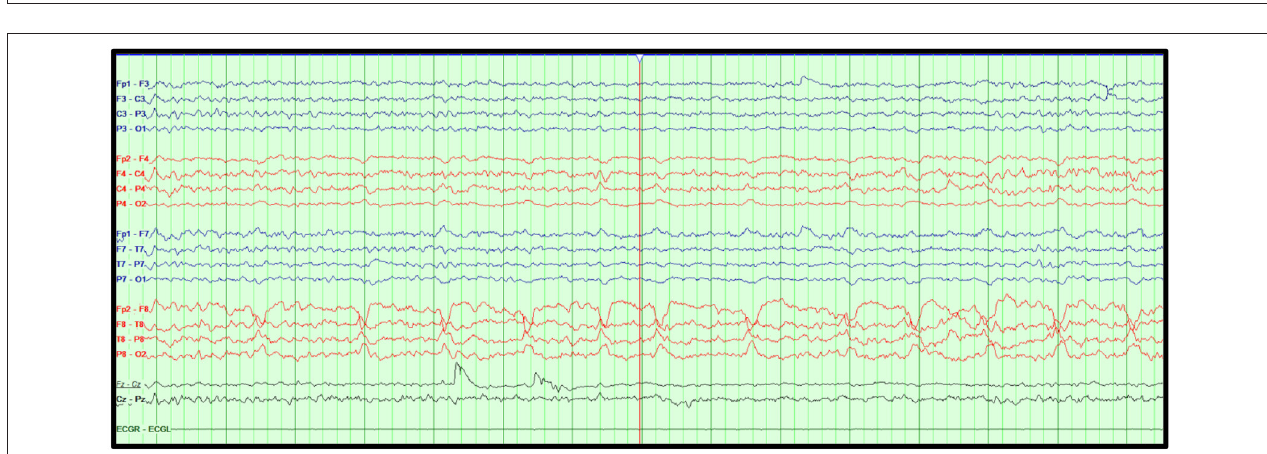
FIGURE 5 | Lateralized periodic discharges. Right temporal periodic discharges in an 18-year-old man with temporal lobe epilepsy with medication non-adherence. Bipolar montage, LFF: 1Hz, HFF: 70Hz, Notch: 60Hz, Sensitivity: 7 µ V/mm, Timebase: 30